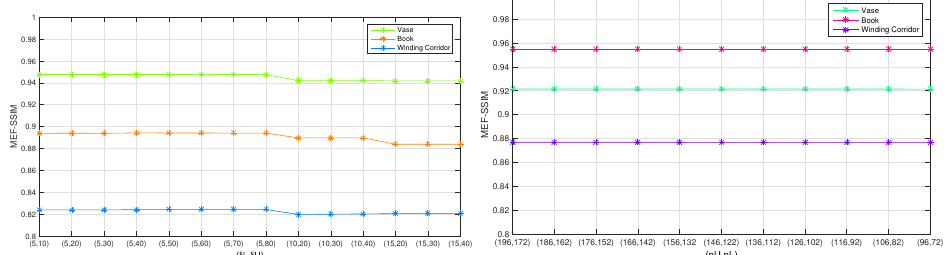
Figure 4. The MEF-SSIM values of the three images under different ξ L , ξ U , η L , and η U parameters. When ξ L is greater than 5, the SSIM value drops due to the high quality of the camera, as shown on the left. The indexes of different η L and η U parameters in terms of MEF-SSIM are shown on the